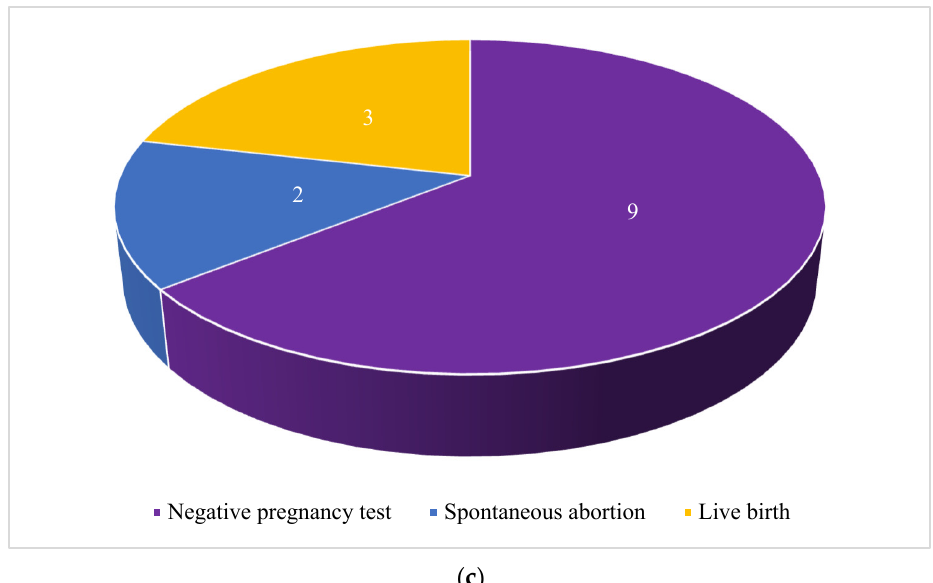
Figure 1. Embryo transfer types and outcomes: ( a ) Total number of embryo transfers by transfer type ( b ) Total number of embryo transfers by pregnancy outcome ( c ) Total number of tested euploid embryo transfers by pregnancy outcome. Six patients, one with EMCA and five with EH, elected to use PGT-A (Table 3). A total